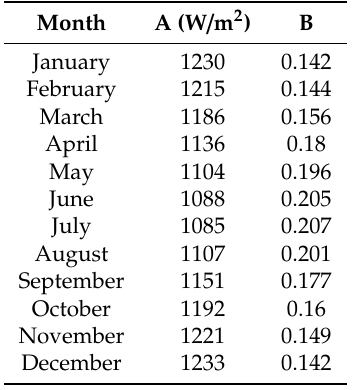
Table 1. ASHRAE clear-sky model data for the 21st day of each month [39]. A (W/m 2 )